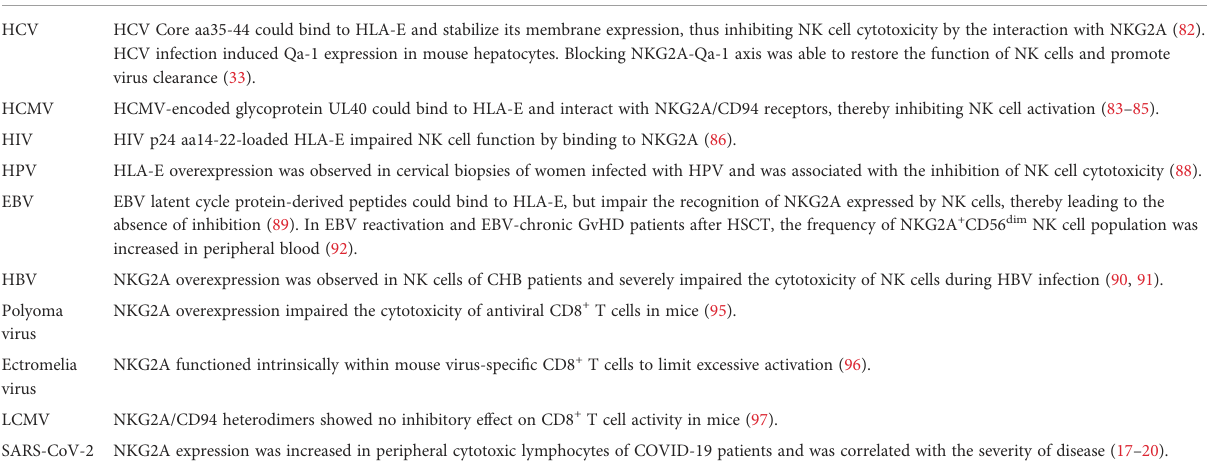
TABLE 2 Roles of NKG2A-HLA-E axis in viral infections. Condition Roles of NKG2A-HLA-E axis